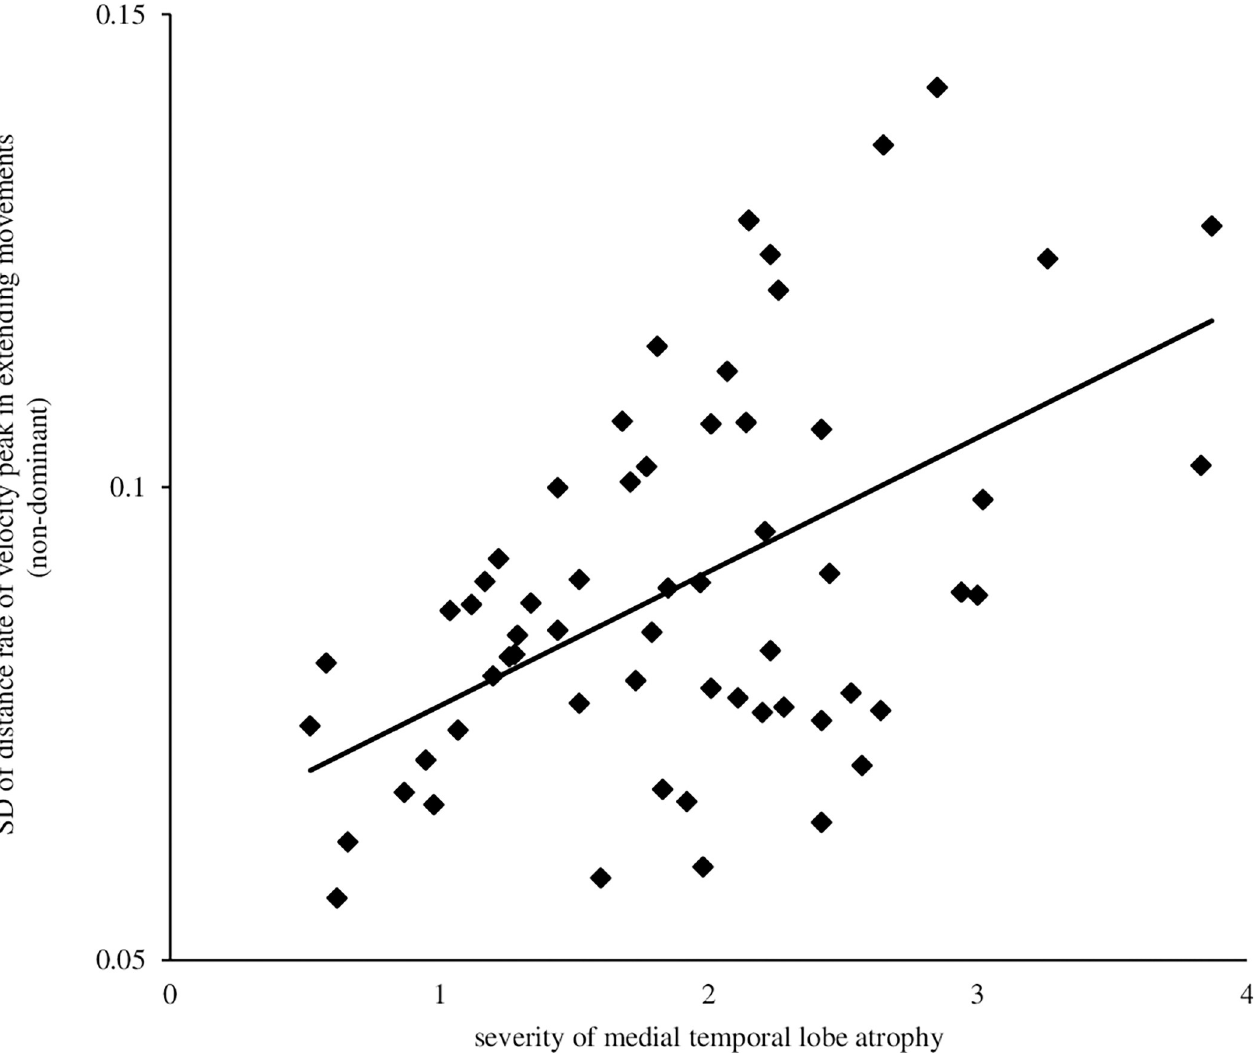
Fig 5. Relationship between finger-tapping parameters and severity of medial temporal lobe atrophy. The vertical and horizontal axes indicate the parameters of the finger-tapping movements and severity of medial temporal lobe atrophy. The SD of distance rate of velocity peak in extending movements of the non-dominant hand was r = 0.51 and p < 0.001. The SD of distance rate of velocity peak in extending movements is defined as the SD of the value calculated as the position of the distance at which the velocity is maximal during the finger opening movement as a ratio to the